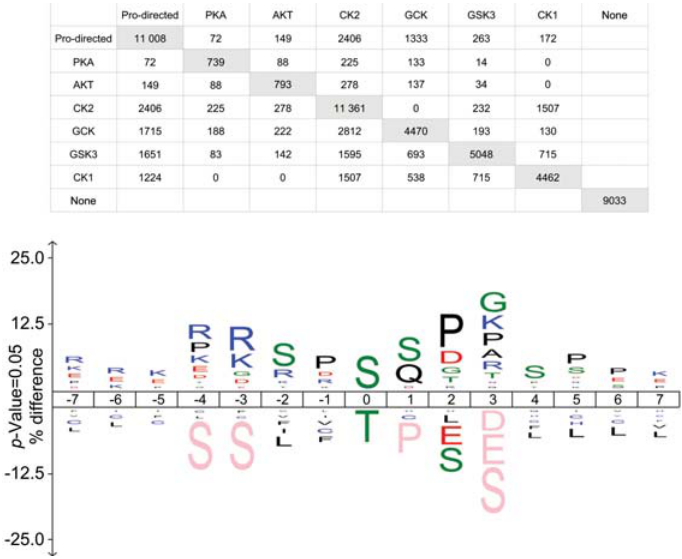
Figure 7 Grouping of human proteome Ser/Thr phosphosites according to the presence of consensus sequences specifically recognized by a number of pleiotropic protein